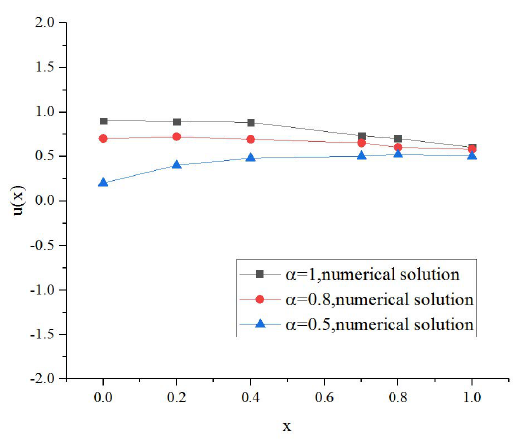
Fig. 2 Numerical solutions of the integral equation at different values when m = 16.